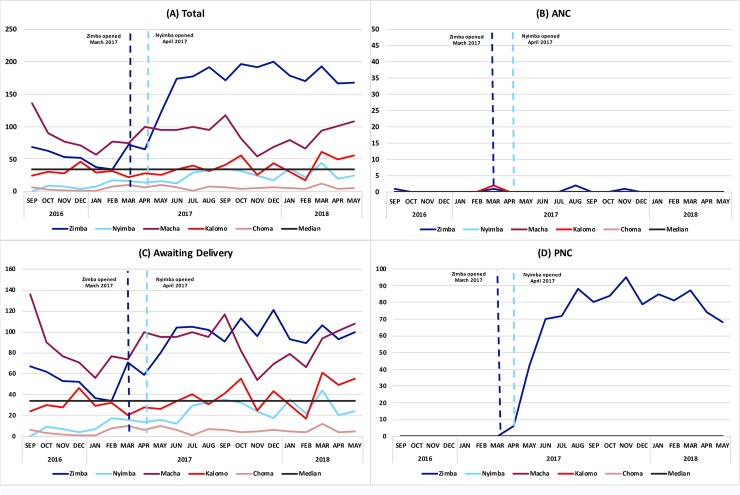
Figs depicting mean number of women utilizing MWHs per month, stratified by: any utilization (1A), utilization for ANC (1B), utilization while awaiting delivery (1C), and utilization for PNC (1D), with each MWH represented by a colored line.